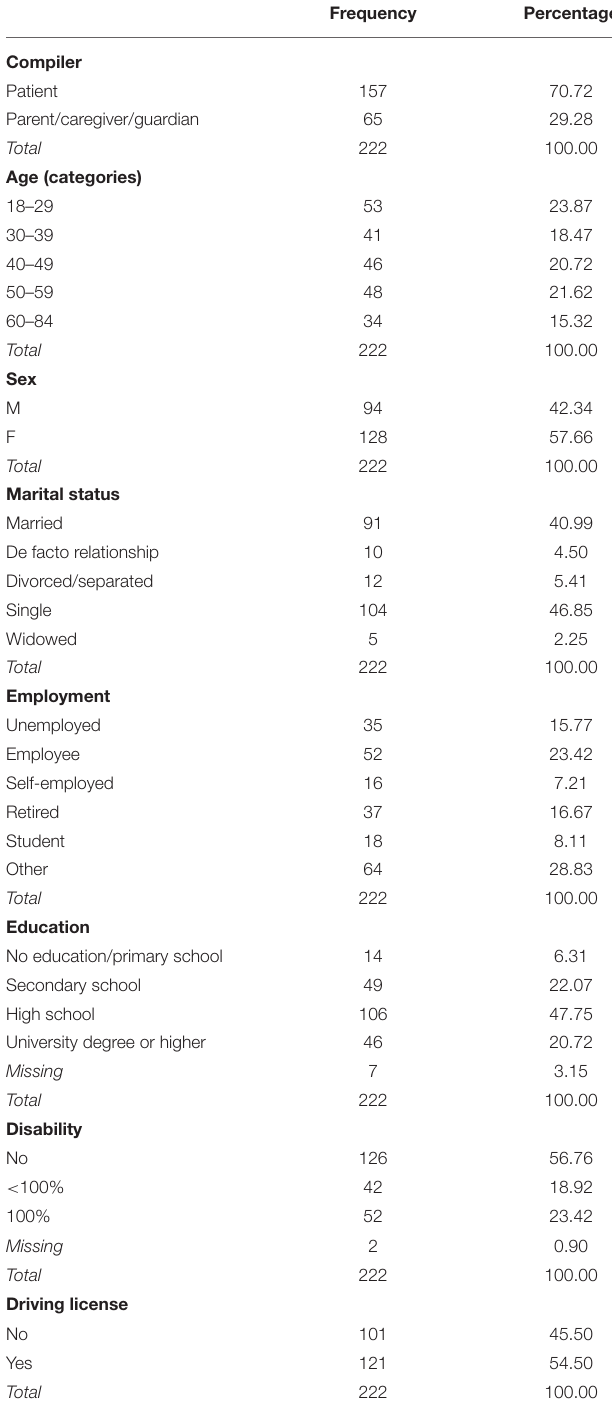
TABLE 2 | General characteristics of the